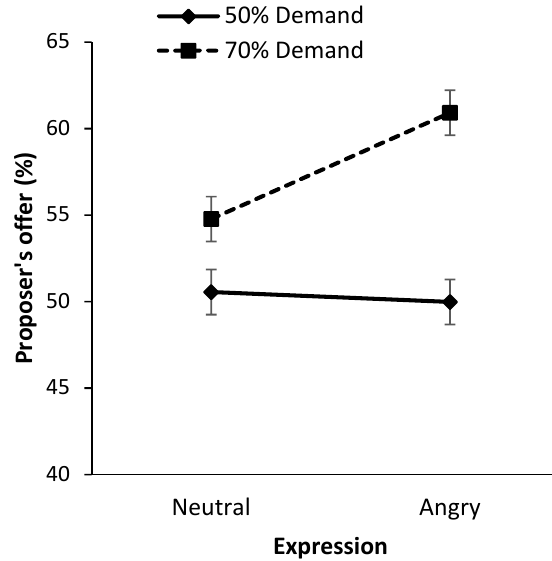
Figure 2. Mean proposer offer by facial expression (neutral or angry) and the size of the demand (50% or 70%) in the threat. Error bars represent ± 1 SE. Reprinted from [31].